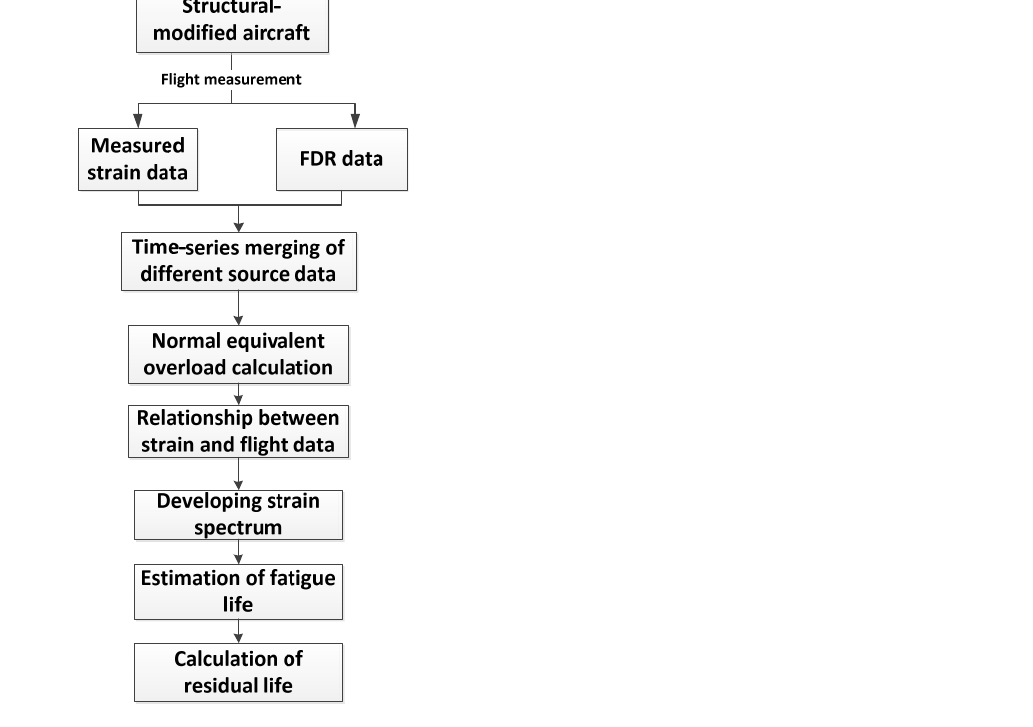
Figure 8. Flowchart of strain spectrum development from flight tests and fatigue life estimation for aging aircraft [31].